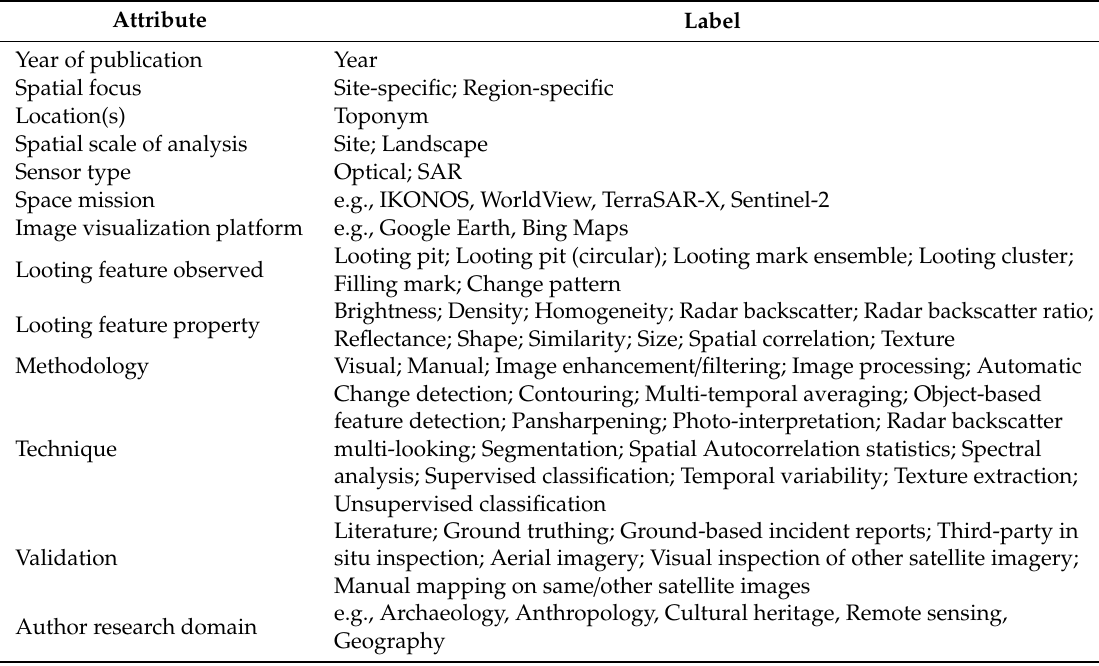
Table 1. Attributes by which scientific papers, grey literature and relevant information therein were classified for the analysis of methods for archaeological looting investigation with satellite